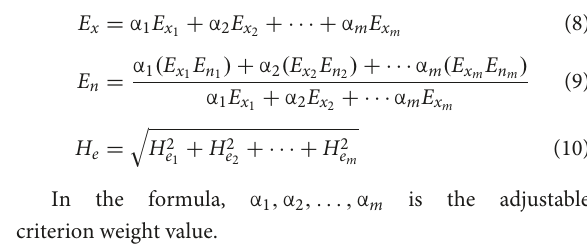
TABLE 1 Importance